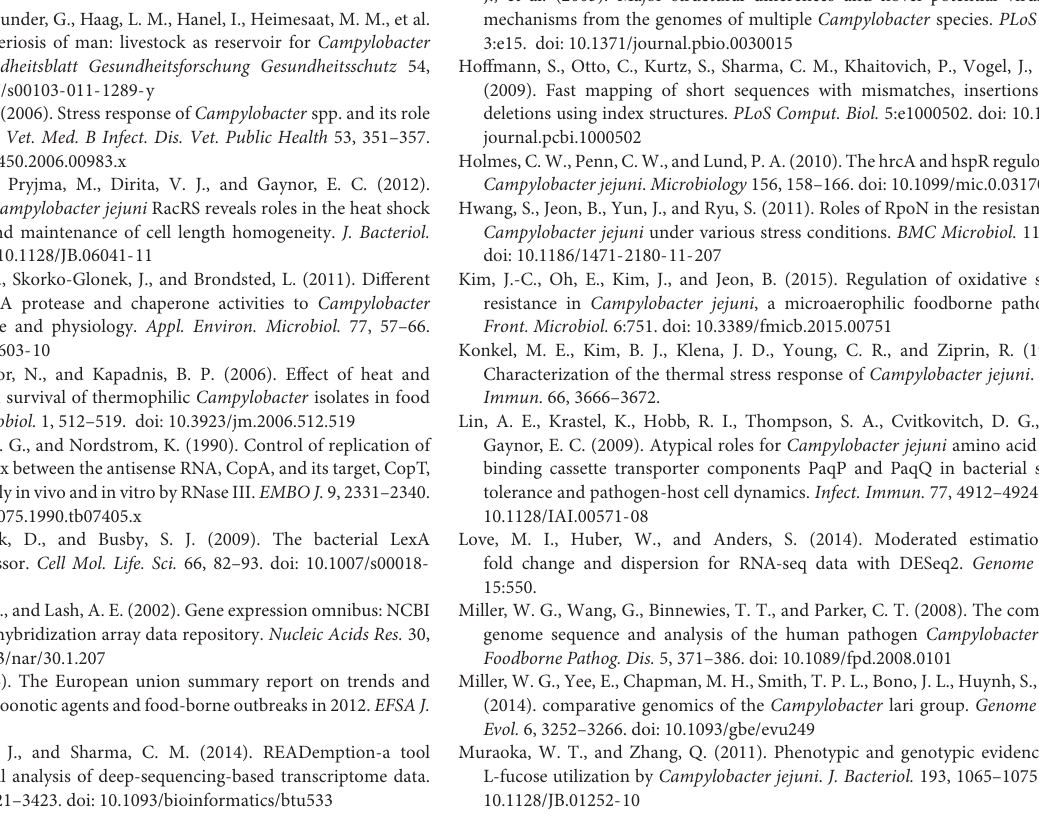
TABLE S4 | Percentage of differentially expressed genes after heat stress according to eggNOG functional categories. The table indicates the percentage of regulated genes for each strain and category. Genes assigned in two categories were listed in each category. Significant enrichment was calculated by Fisher’s exact test. ∗ p < 0.05. TABLE S5 | Strains used in this study. The ID, origin, description, and source of each strain used in this study are indicated in this